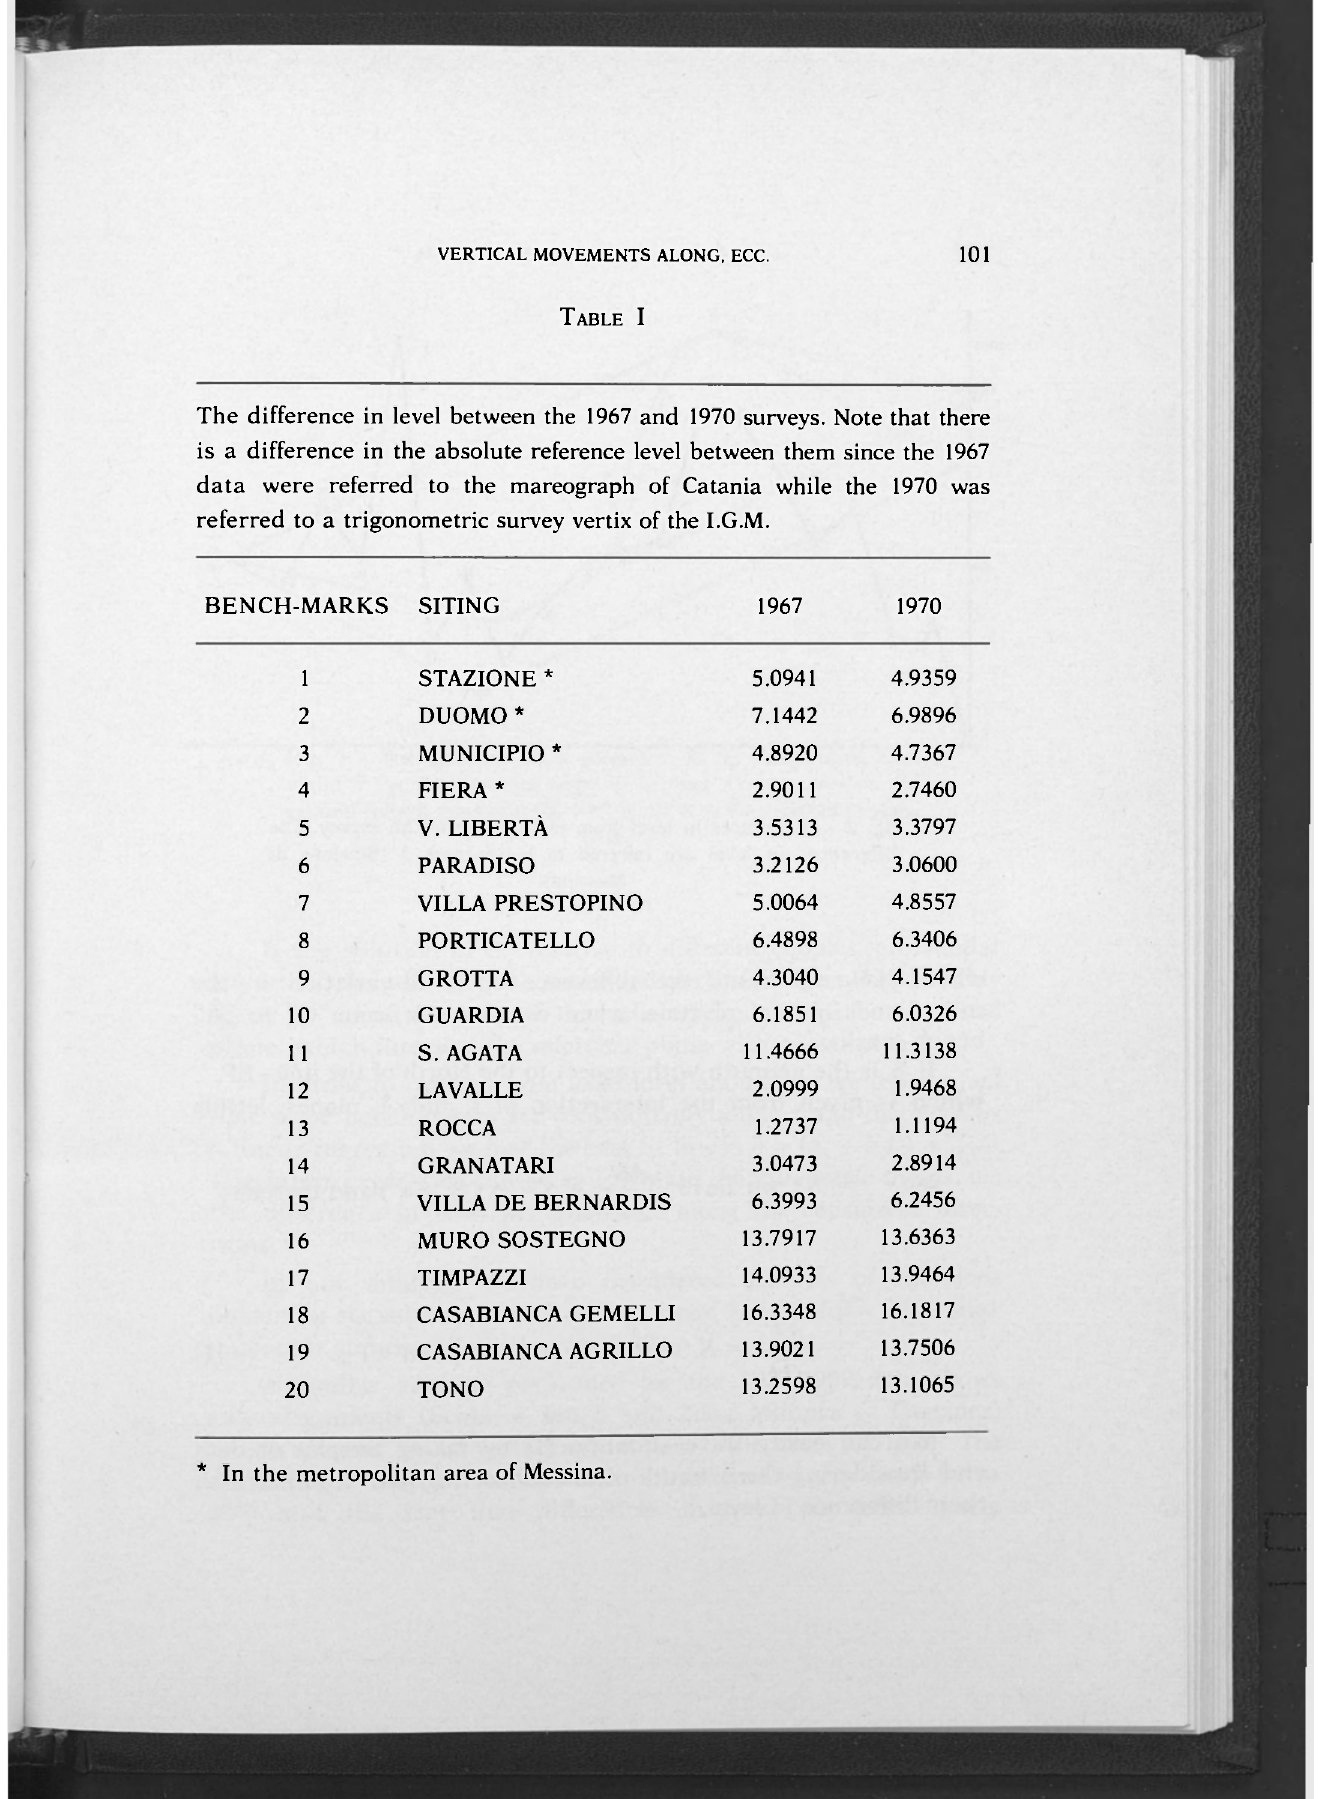
The difference in level between the 1967 and 1970 surveys. Note that there is a difference in the absolute reference level between them since the 1967 data were referred to the mareograph of Catania while the 1970 was referred to a trigonometric survey vertix of the